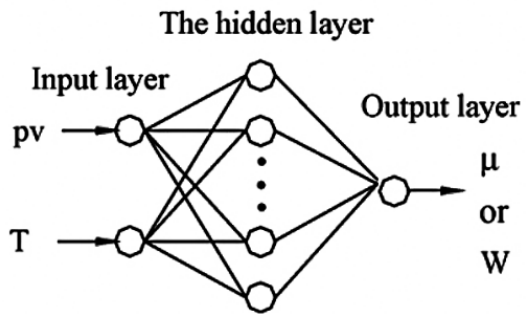
Figure 12. Diagram of a BP neural network model. Adapted with permission from Ref. [91]. 2007, Elsevier.